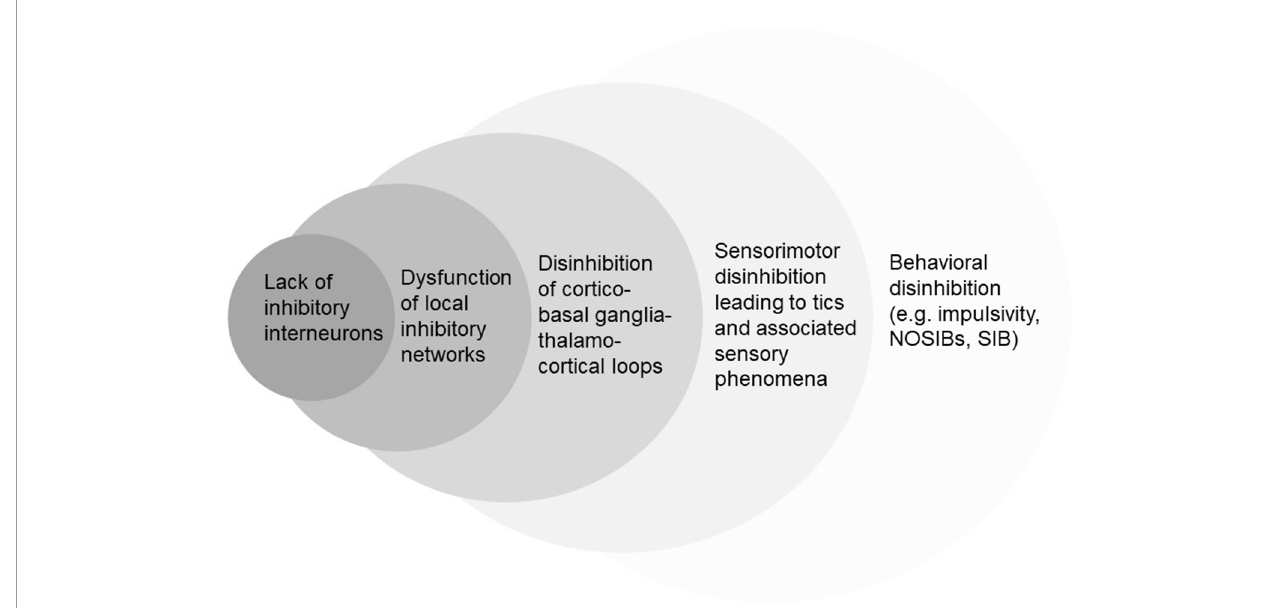
FIGURE 2 | Simpli fi ed hierarchic representation of different conceptual levels of disinhibition in TS. NOSIBs; Non-Obscene Socially Inappropriate Behaviors. SIB; Self-Injurious